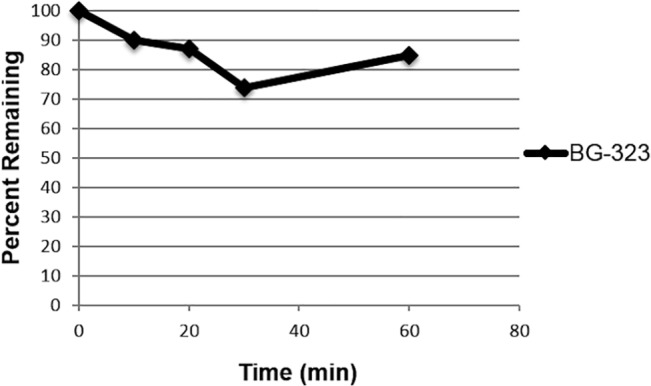
Metabolic stability in human liver microsomes.BG-323 was incubated with pooled human liver microsomes. After reaction initiation with NADPH, reactions were sampled at times 0, 10, 30 and 60 minutes. BG-323 concentrations were determined by LC-MS/MS at each time point (n = 1).